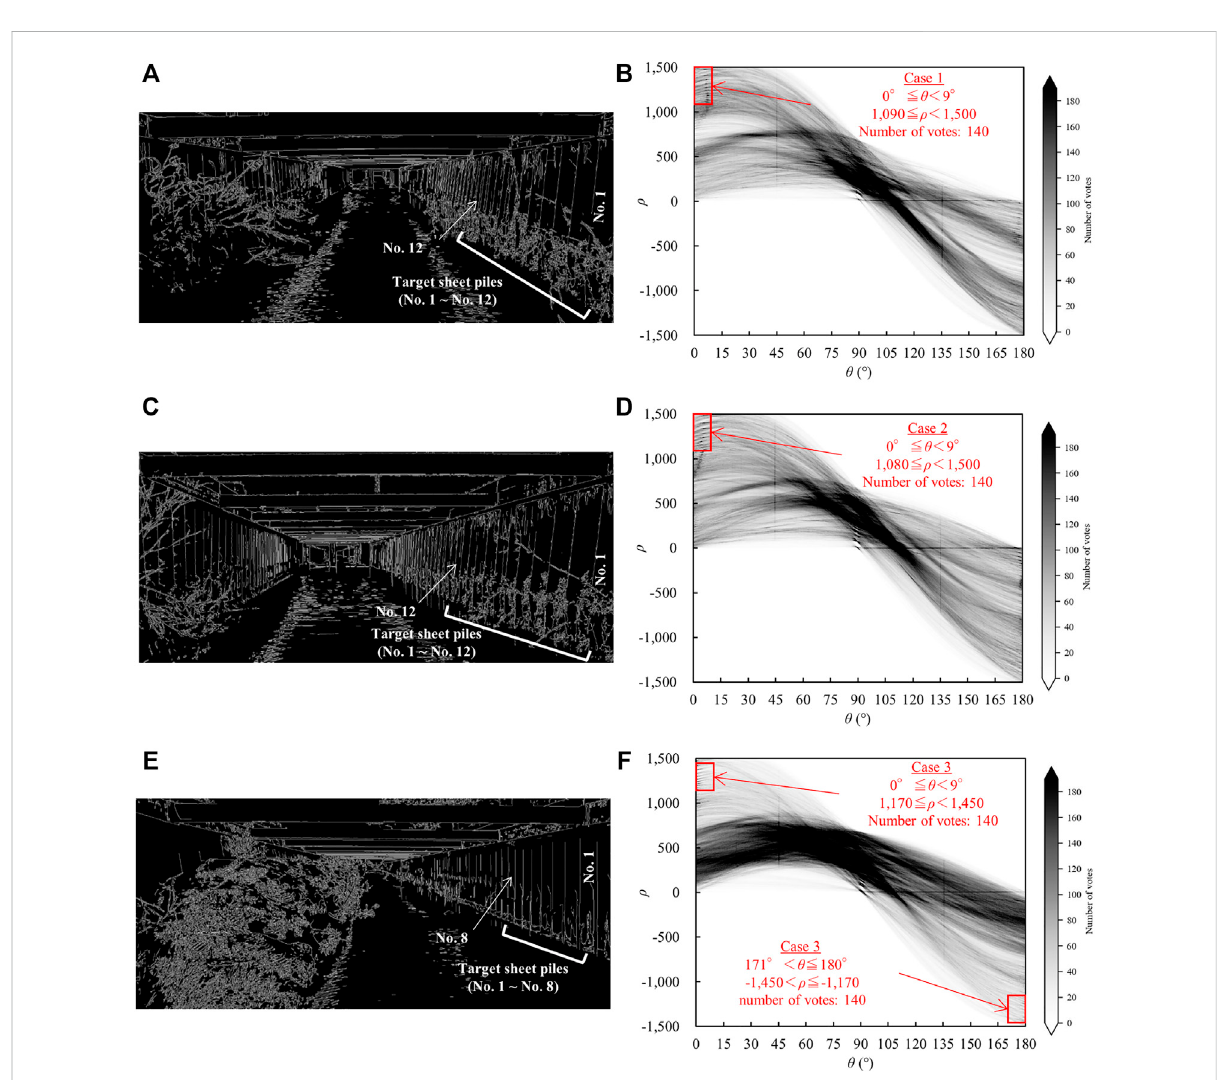
FIGURE 8 ResultsofHoughtransform. (A) AnedgeimageinCase1. (B) VotingedgesinCase1totheparameterspacebyEq.1. (C) AnedgeimageinCase2. (D) Voting edges in Case 2 to the parameter space by Eq. 1. (E) An edge image in Case 3. (F) Voting edges in Case 3 to the parameter space by Eq.